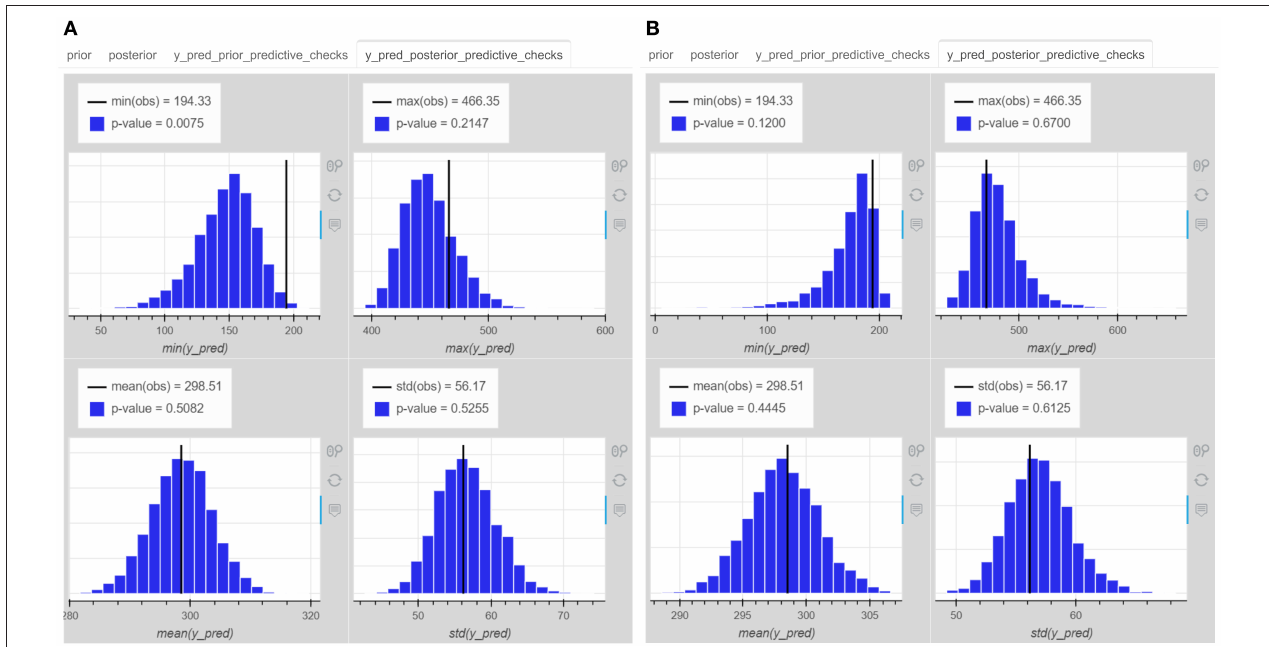
FIGURE 7 | The posterior predictive test statistics of (A) the pooled reaction times model, (B) the hierarchical reaction times model. The hierarchical model improves representation of the “min” “max”, and “std” test statistics of the observations in the predictions.